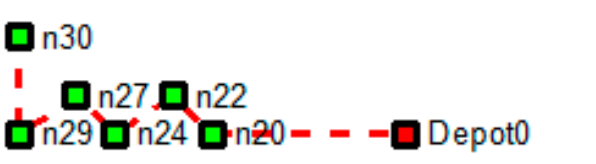
Figure 5. Partial route of route 2.